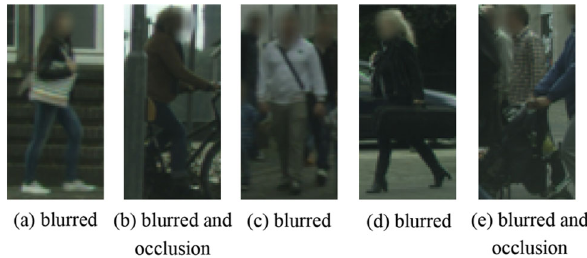
Fig. 18 Examples of images of complex situations in the Cityscapes data set